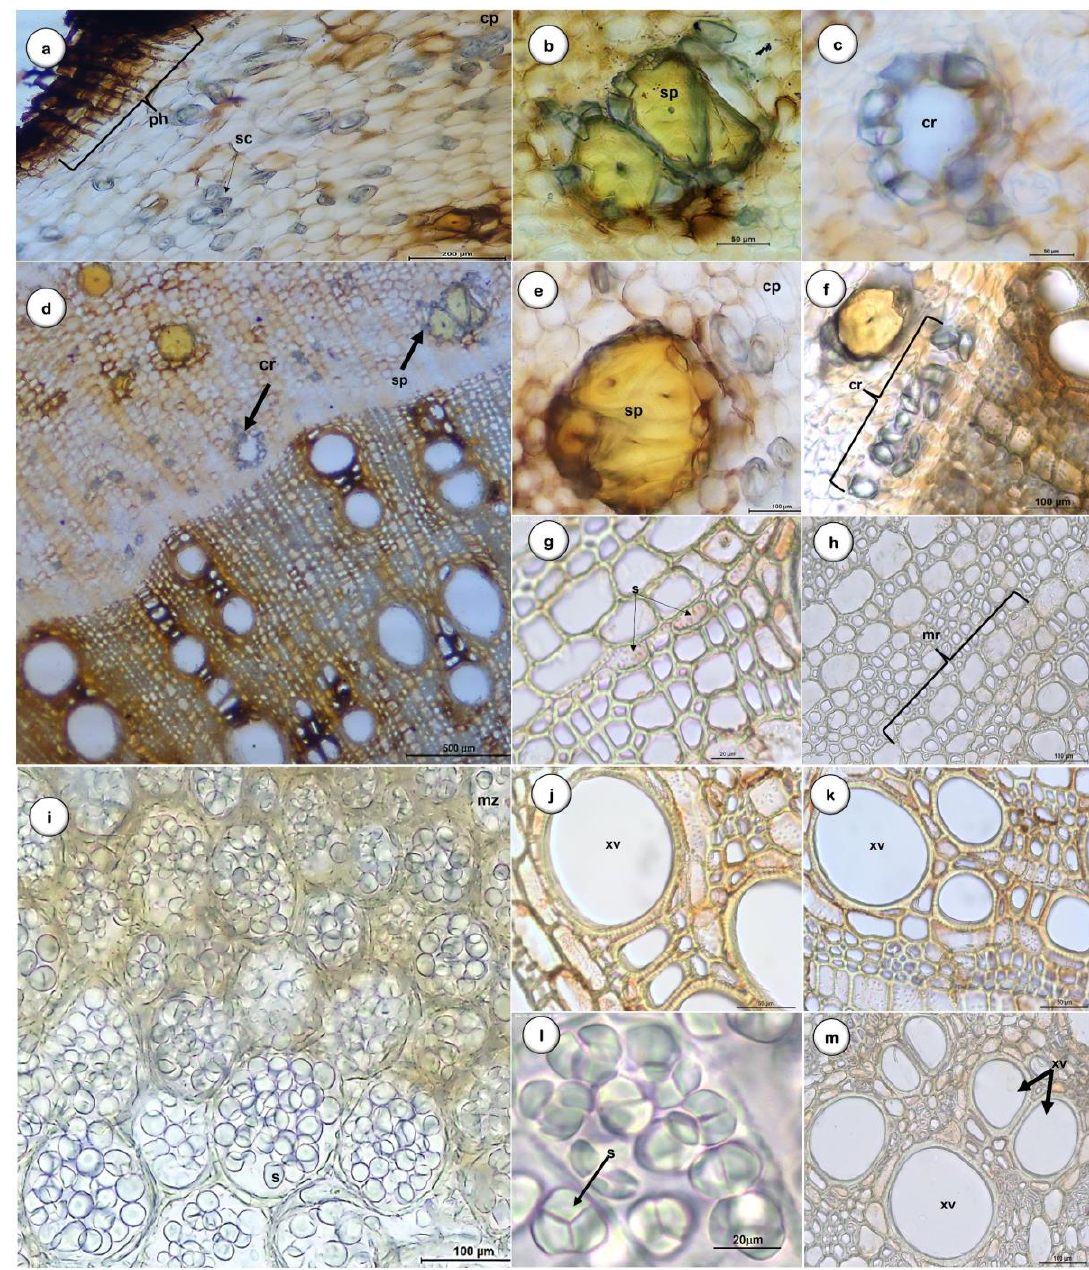
Figure 4. Transverse section of D. villosa root. ( a ): General aspects of periderm and cortical parenchyma, peripheral zone detail with phellem, phellogen, and phelloderm; ( b – f ): View of the cortical parenchyma and the separation zone of the vascular cambium between the secondary phloem and secondary xylem; ( b – f ): Cortical parenchyma cells with isolated brachysclereids and sclereids in groups; ( f ): Brachysclereids with a ring of prismatic calcium oxalate crystals; ( g , h ): Xylem and medullary rays uniseriate; ( i – l ): Medulla with storage parenchyma and starch grain detail with y-shaped hilum; ( j , k , m ): Detail of single or double xylem vessels. Bars: a = 200 µm; b, c, j, and k = 50 µm; d = 500 µm; e, f, h and m = 100 µm; g and l = 20 µm. Abbreviations: cp, cortex parenchyma; dr, druse calcium oxalate; cr, prismatic calcium oxalate crystals; mr, medullary rays; mz, medulla zone; ph, phloem; pz, periderm zone; s, starch grain; sc, stone cells; sp, polygonal sclereids; xv, xylem vessels.